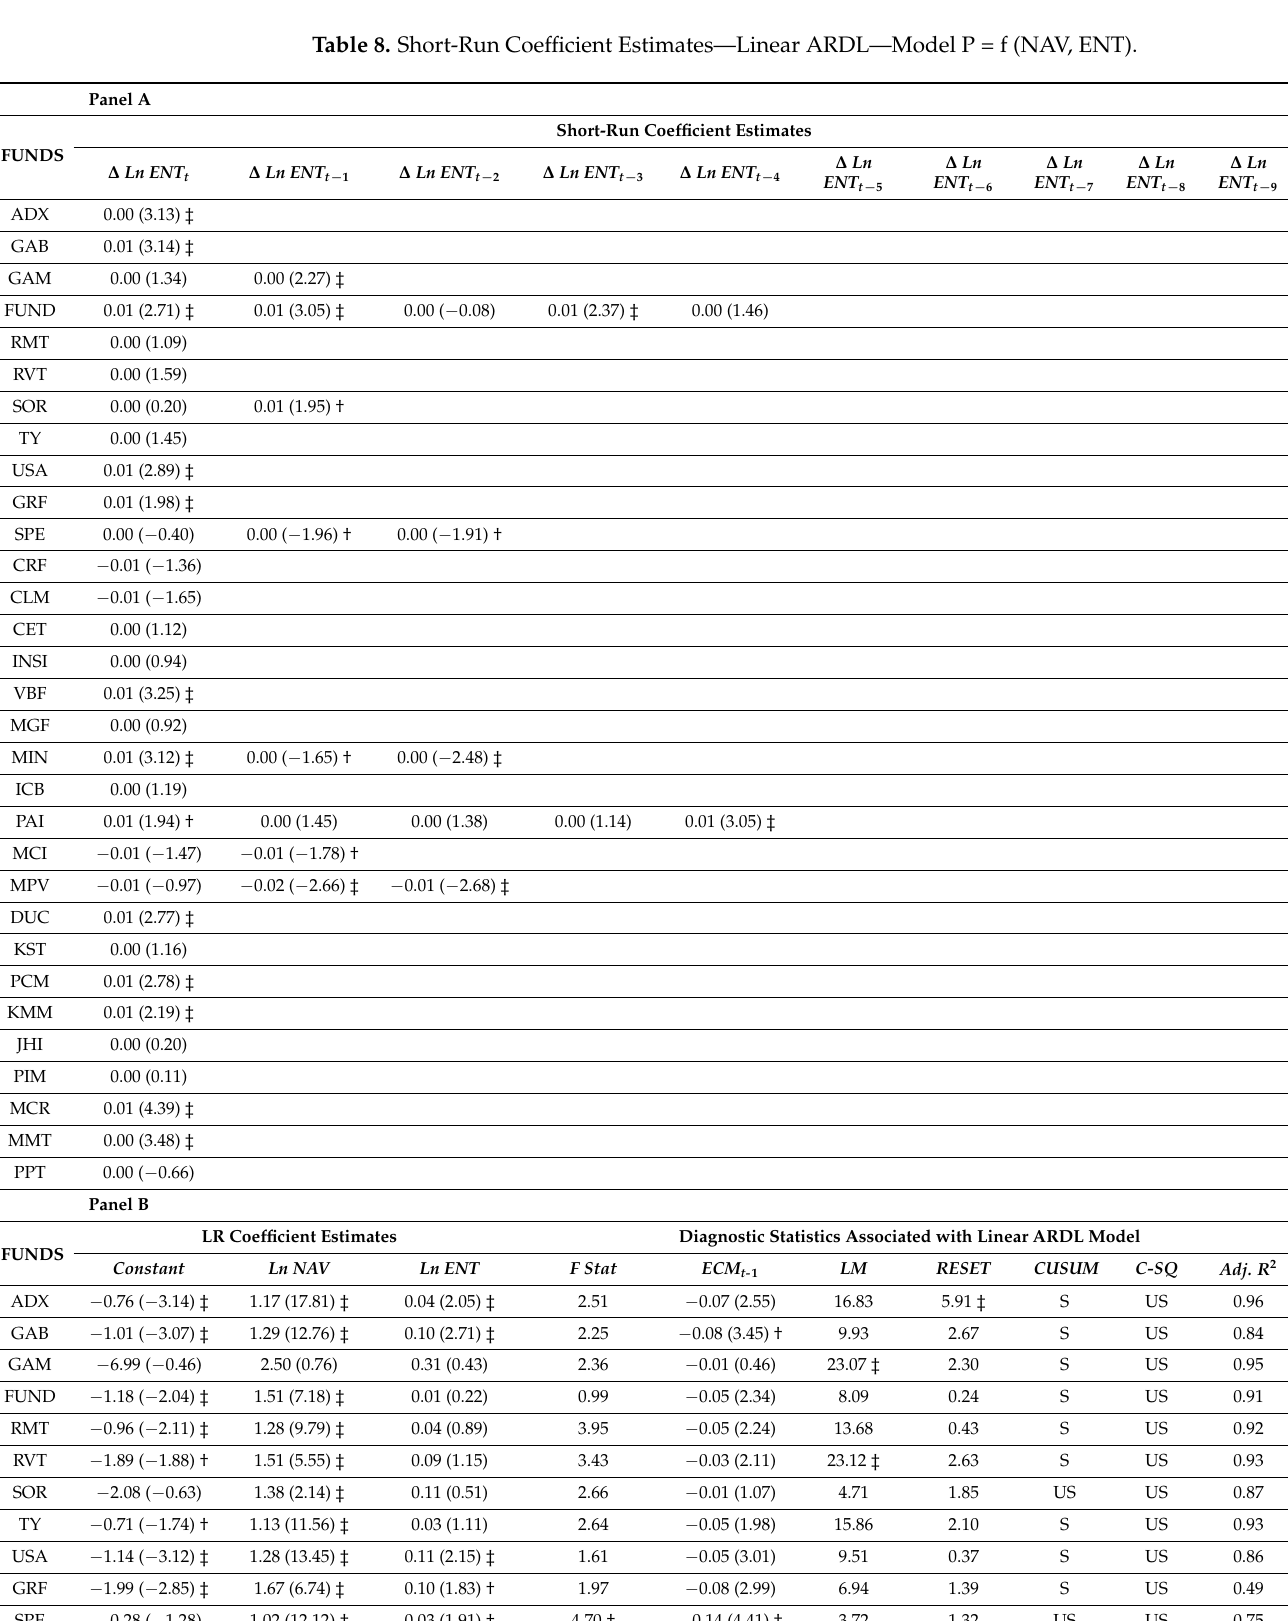
Table 8. Short-Run Coefficient Estimates—Linear ARDL—Model P = f (NAV,